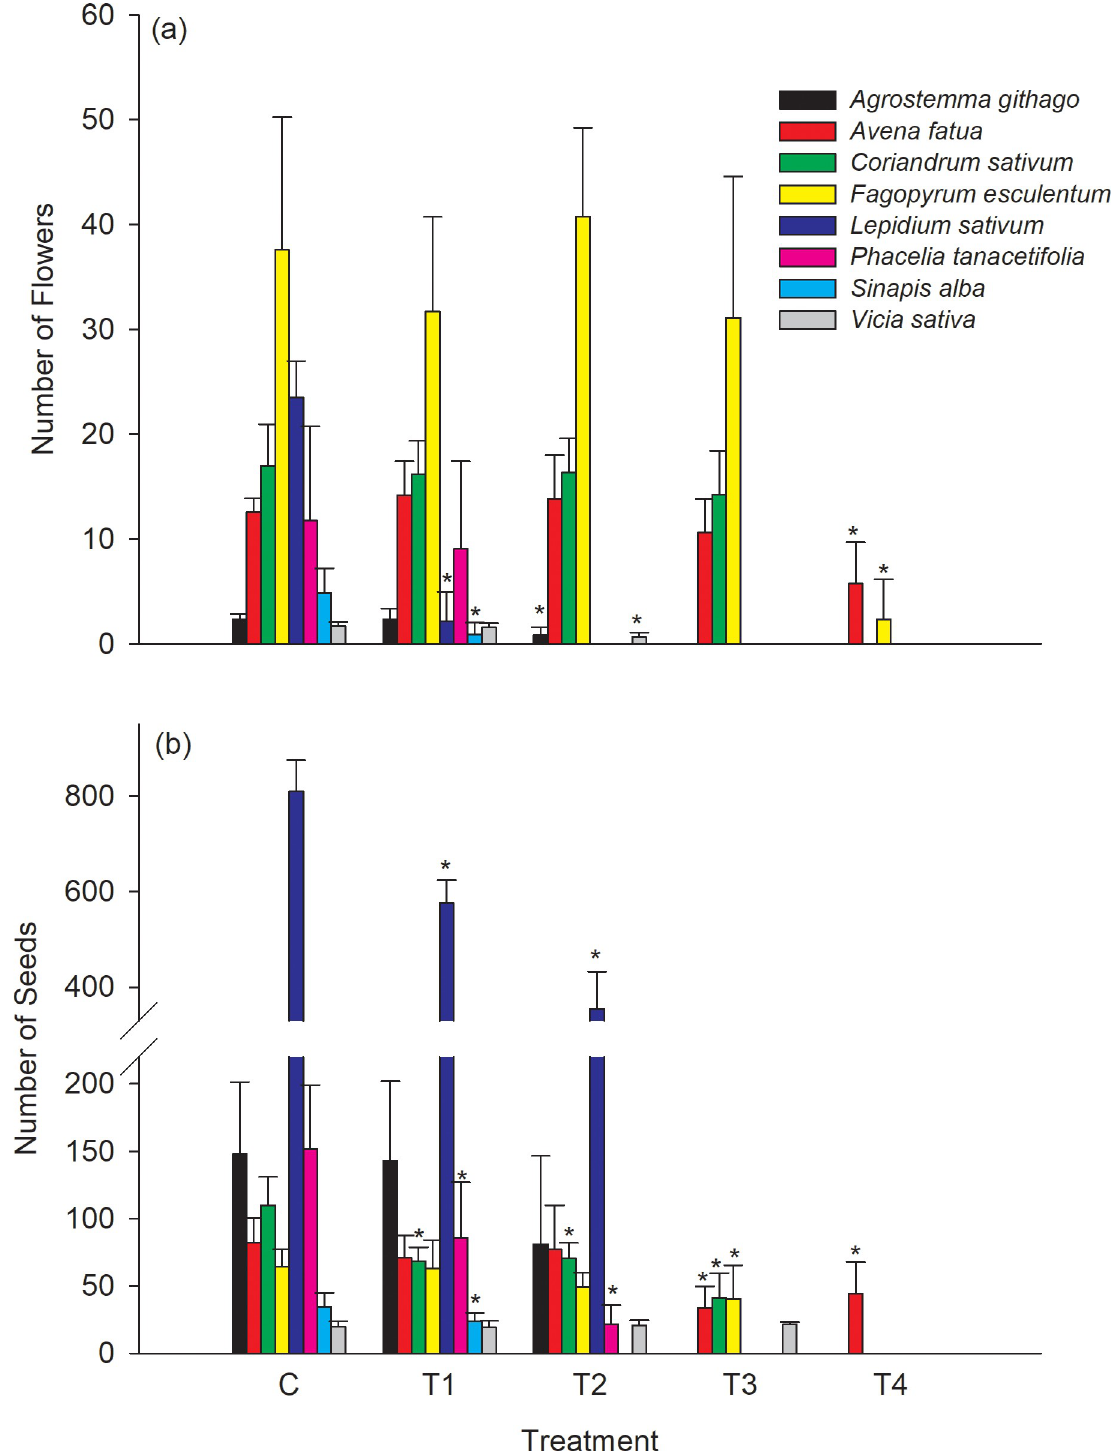
Fig 4. Mean number of flowers per plant at BBCH 65 (a) and seeds at BBCH 89 (b), respectively. Error bars indicate the standard deviation and � indicate a statistical significantly difference to the control (William‘s test or Multiple Welch‘s t-test with Bonferroni-Holm adjustment depending on homoscedasticity) for each plant species ( α = 0.05, one sided smaller). Missing columns within a treatment group indicates that no data could be assessed for the respective plant species.